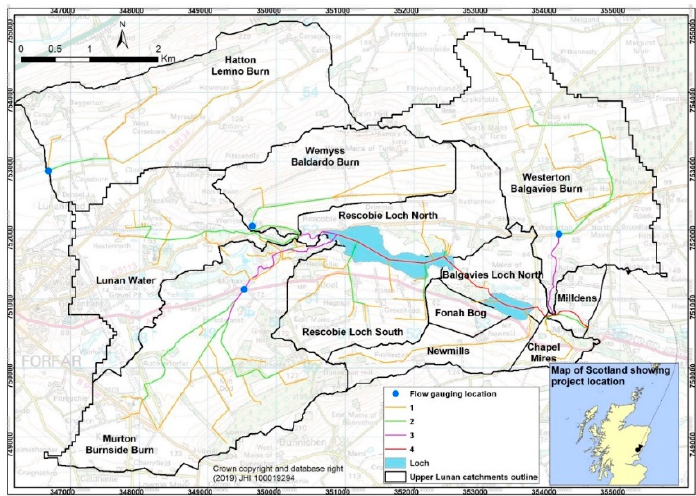
Figure 3. Sub-catchments in the upper Lunan Water. The flow gauging station / watercourse for the three monitored sub-catchments are: Westerton / Balgavies Burn (A catch = 590 ha), Wemyss / Baldardo Burn (A catch = 238 ha), and Hatton / Lemno Burn (A catch = 710 ha). The total catchment area of Rescobie Loch is 2016 ha. The line colouring shows the stream order. Regular water chemistry sampling takes place at the three flow gauging stations and the SEPA run station at Murton / Burnside Burn.